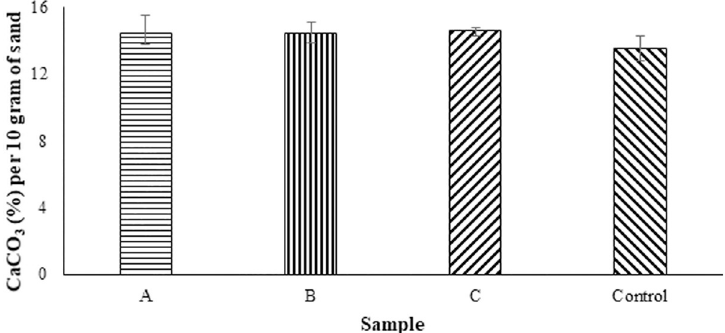
Fig 7. Percentage of CaCO 3 per 10 grams of sand measured via titration A = Pseudomonas nitroreducens szh_asesj15 (Mean: 14.42, Std. Dev.: 0.97); B = Bacillus sp. xjlu_herc15 (Mean: 14.63, Std. Dev.: 0.32); C = Bacillus licheniformis adseedstjo15 (Mean: 14.43, Std. Dev.: 0.62) and Control = Bacillus megaterium (Mean: 13.56, Std. Dev.: